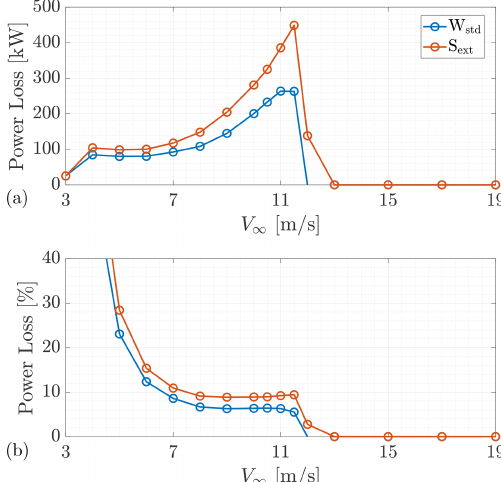
Figure 25. Power losses with a steady inflow. (a) Absolute differ- ence. (b) Normalised